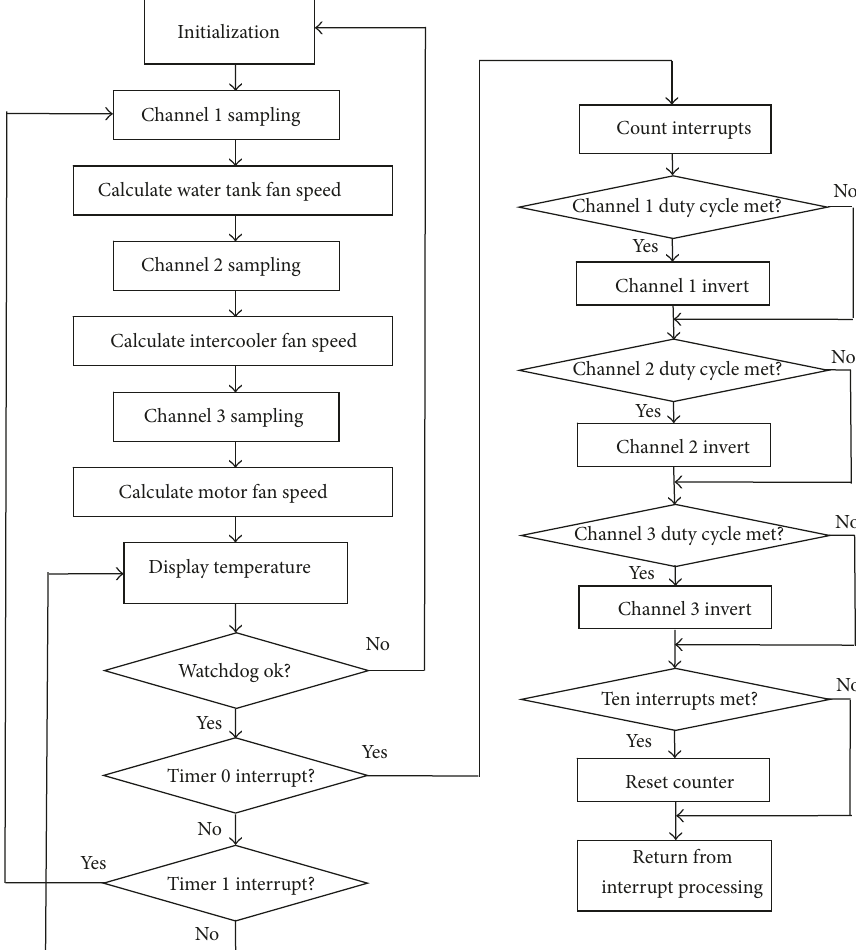
Figure 8: The flow chart of the ECU control software.